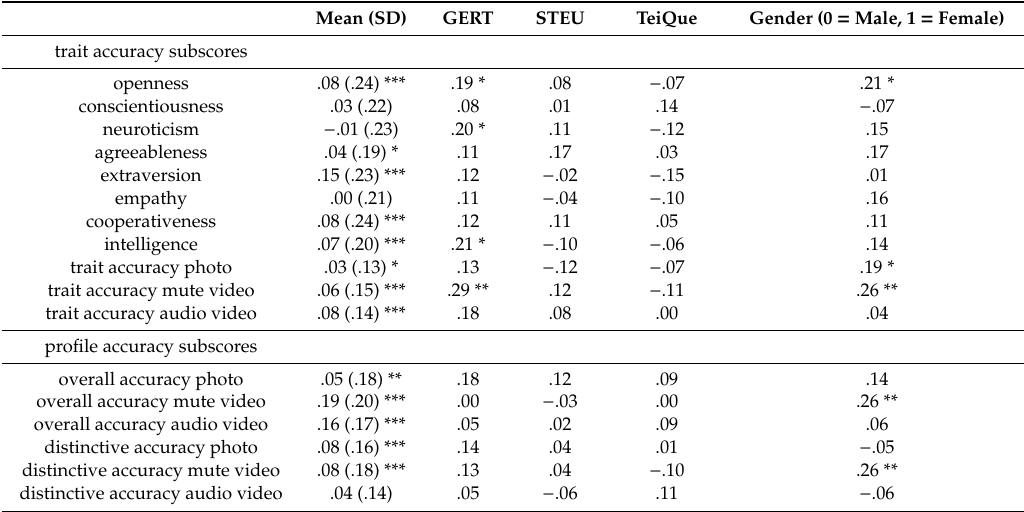
Table 2. Descriptives for Personality Judgment Subscores and Spearman Rank Correlations with GERT, STEU, and